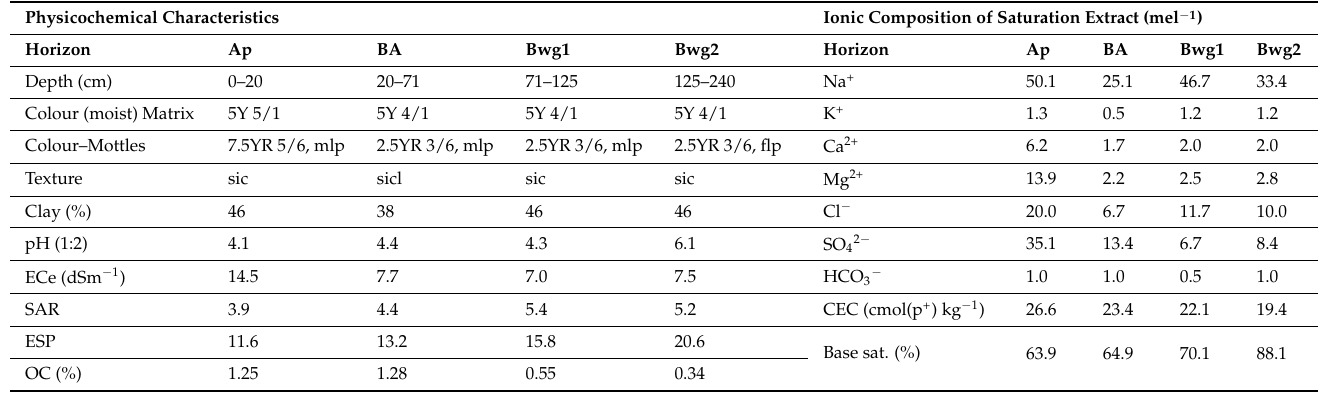
Table 2. Characteristics of acid sulphate soils of Indian part of the Ganges Delta.